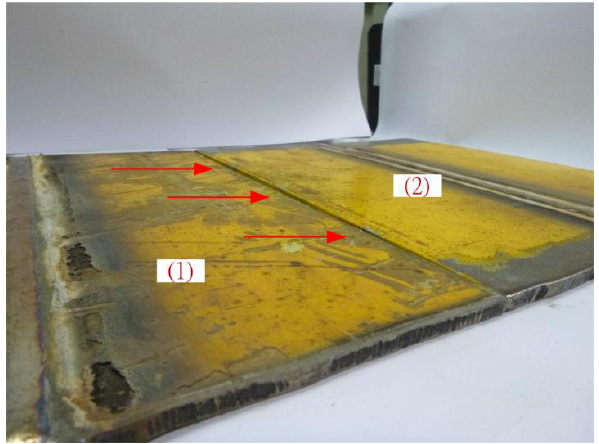
Figure 9. Deformation with and without jig constraints: (1) with, (2) without.